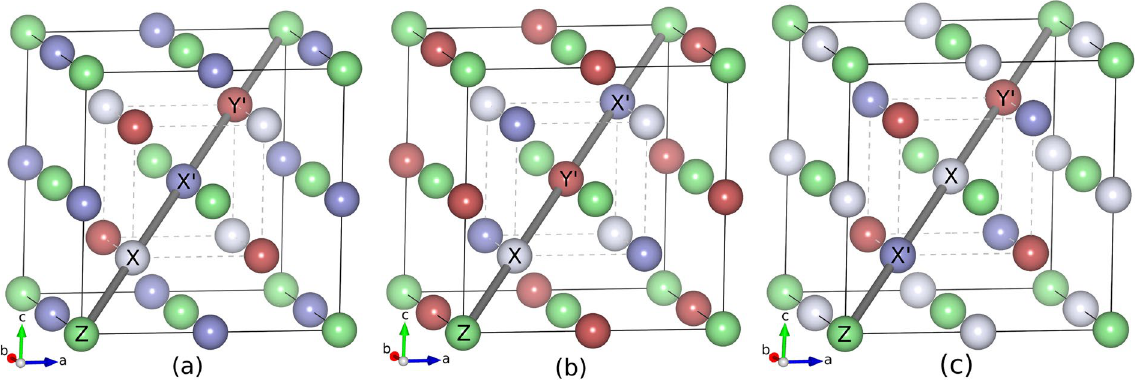
Figure 1. Crystal structure of XX ′ Y ′ Z in ( a ) Type-I (X and Y ′ are in symmetric positions) ( b ) Type-II (X and X ′ are in symmetric positions) ( c ) Type-III (Y ′ and X ′ are in symmetric positions).